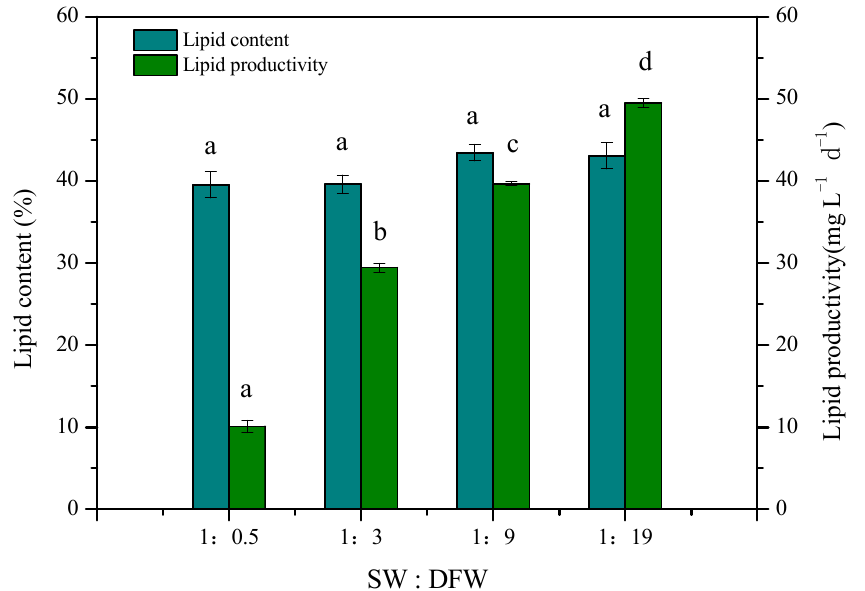
Figure 4. Lipid content and productivity of C. pyrenoidosa cultured in mixed wastewater with different mixture ratio of SW to DFW. Data are shown as mean ± SD, n = 3. Different letters in the same column represent significant differences ( p ≤ 0.05).